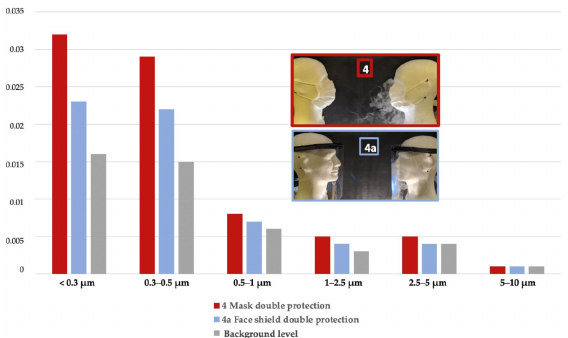
Figure 8. Percentage of Total Inhaled Particles (PTIP) with Double protection (Em+Re): mask vs. face shield for each particle size range compared to lack of